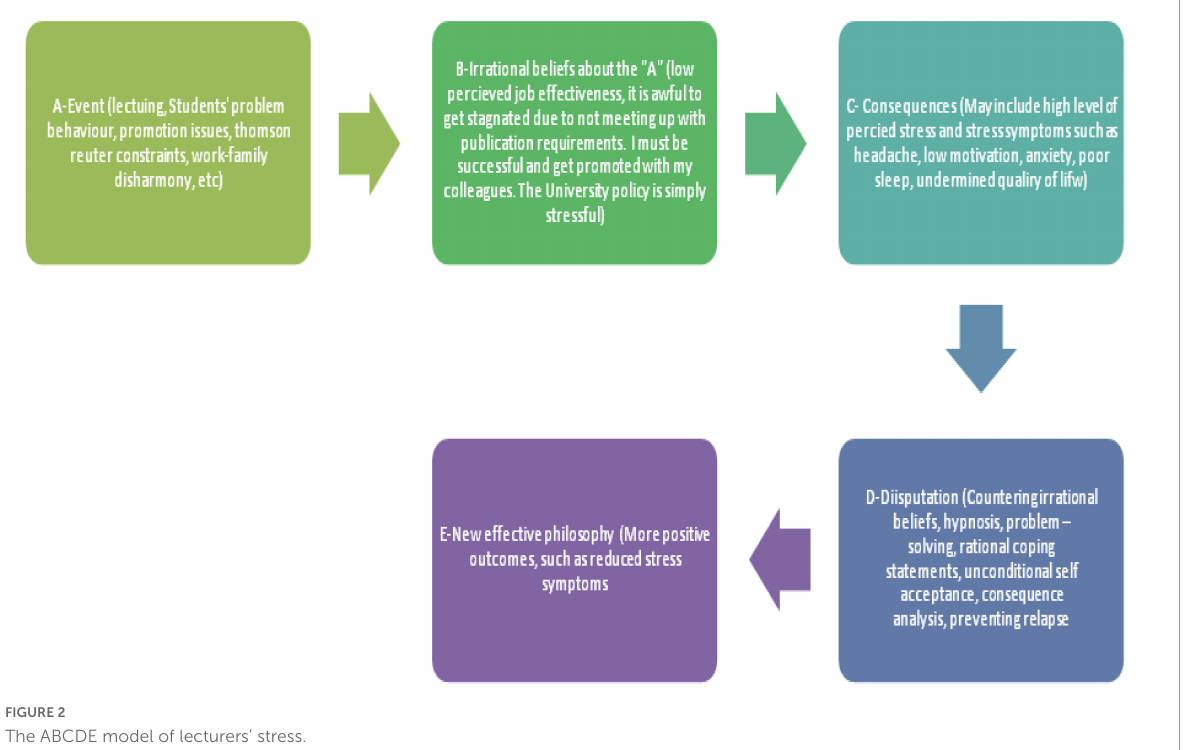
FIGURE2 The ABCDE model of lecturers’